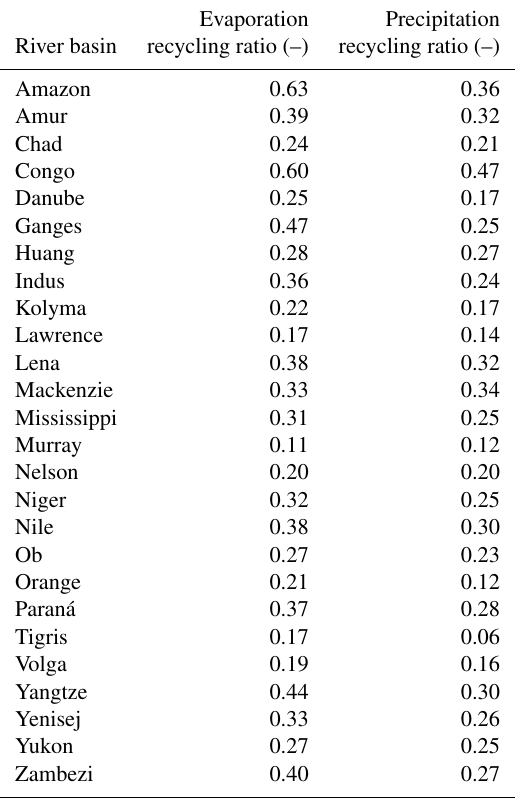
Table 1. Average evaporation and precipitation basin recycling ra- tios for the 26 largest basins of the